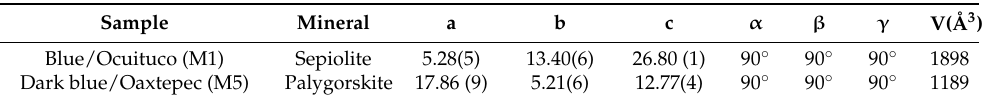
Table 6. Cell parameters for sepiolite (sample M1) and palygorskite (sample M5) calculated by Rietveld refinement